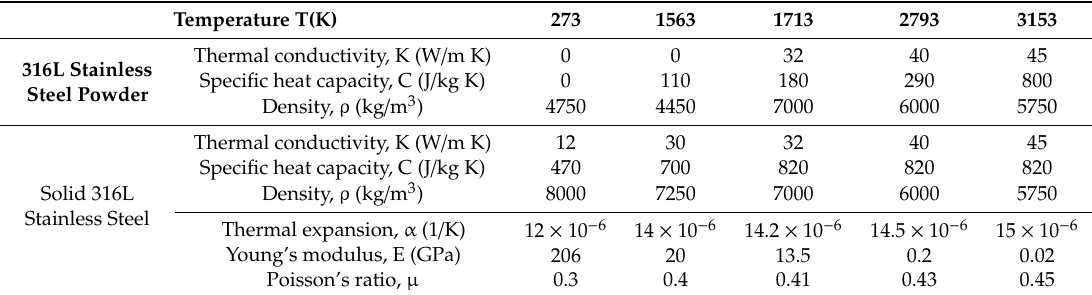
Table 1. Thermal physical parameters of 316L stainless steel (Date from literature